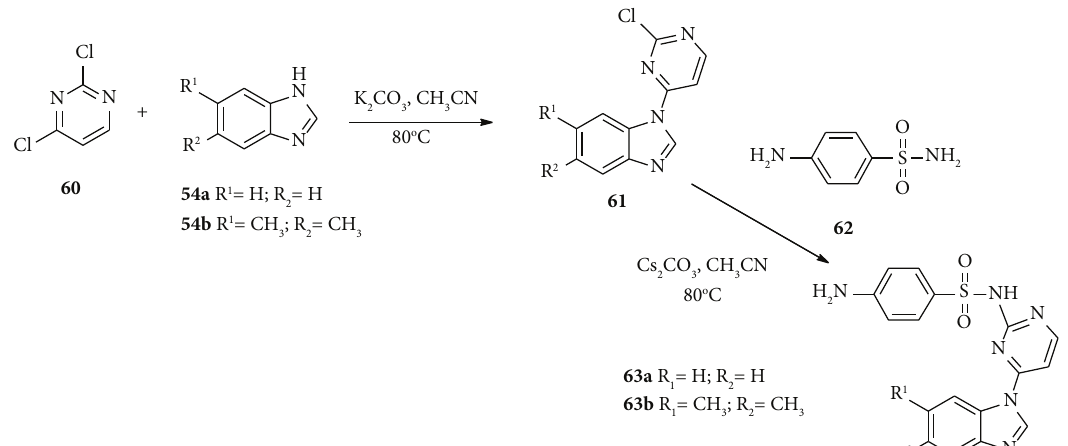
Scheme 10: Synthetic routes towards compound 63 derivatives.